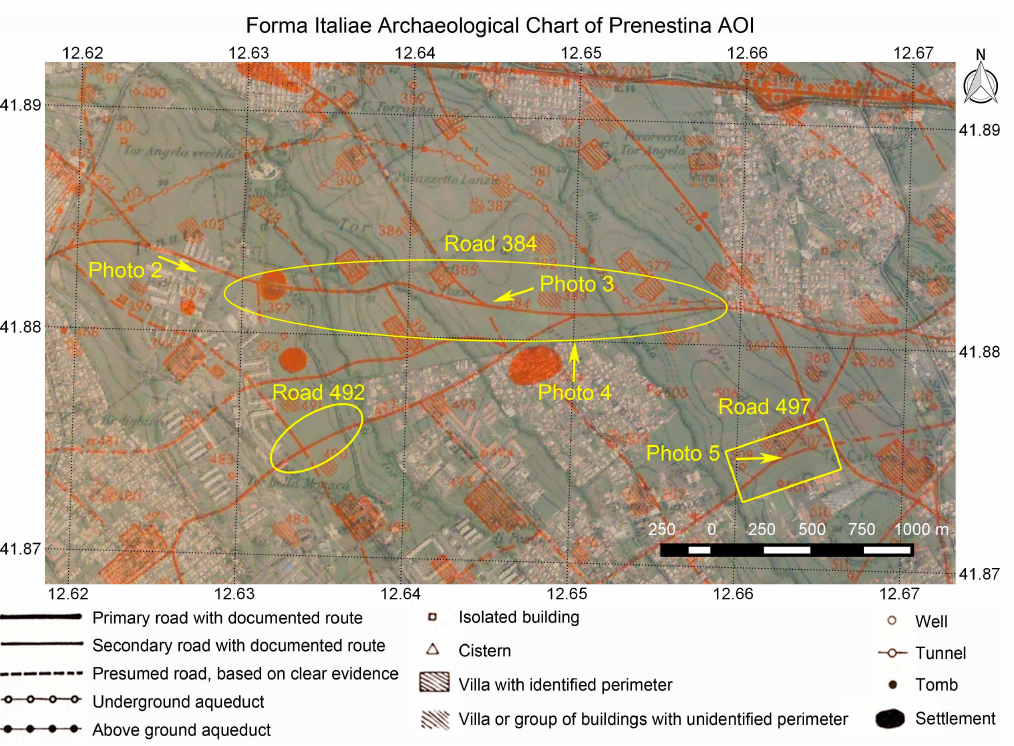
Figure 31. Subset of archaeological chart over the Prenestina AOI taken from Quilici, 1974 [46] and published as part of the Forma Italiae series. Annotations in red show documented archaeological structures, annotations in yellow show the locations of residues and the locations and directions from which photographs were acquired on the ground.